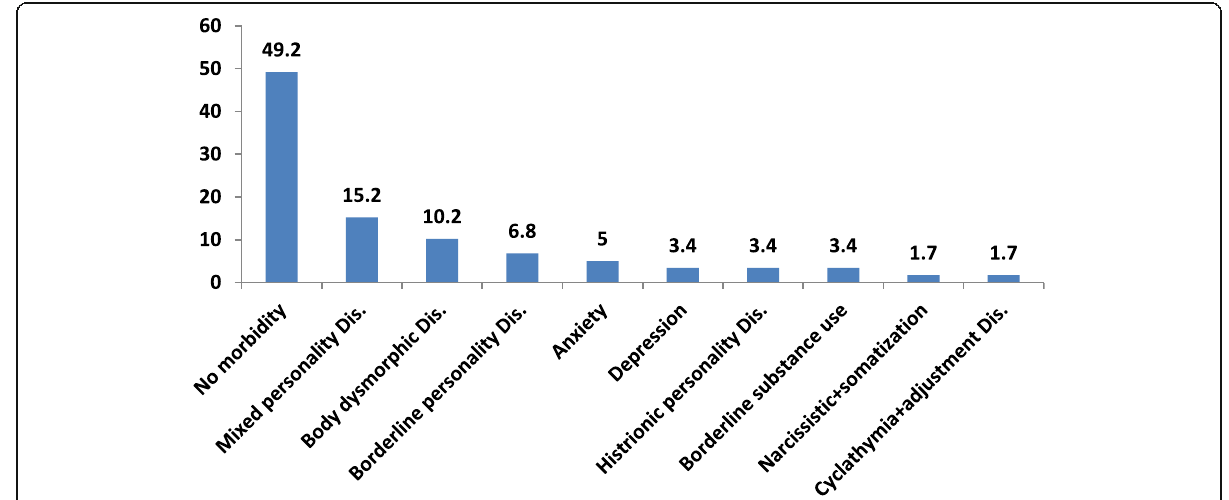
Fig. 2 Pattern of psychiatric morbidity among patients seeking rhinoplasty